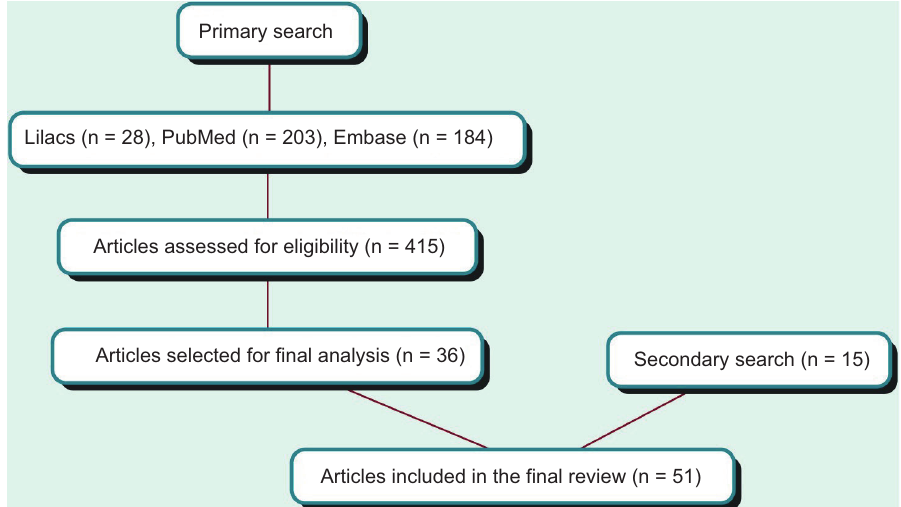
Figure 1: Literature review